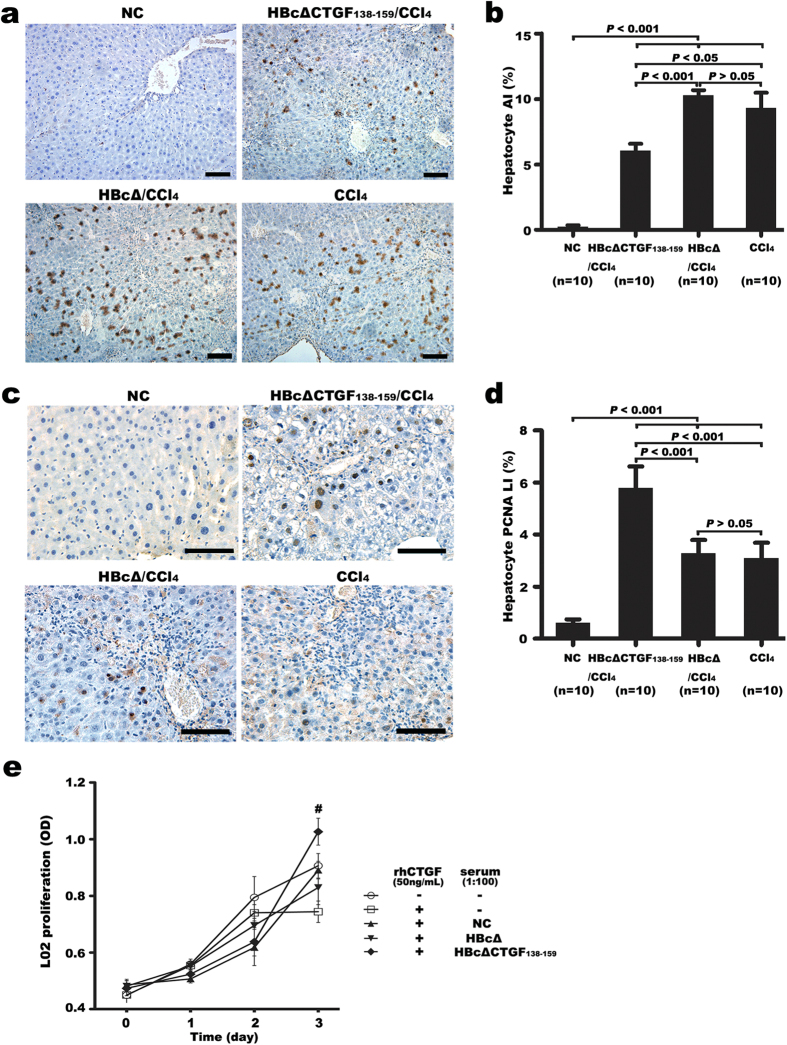
The neutralization of CTGF promoted the proliferation and reduced the apoptosis of hepatocytes in CCl4-induced fibrotic mouse livers.TUNEL staining of the hepatic sections (a) and subsequent apoptosis index (AI) evaluation (b) demonstrated that HBcΔCTGF138–159 vaccination alleviated hepatocyte apoptosis in the fibrotic mouse livers. Immunohistochemically stained of PCNA (c) and subsequent PCNA labelling index (PCNA LI) calculations (d) showed that vaccination with HBcΔCTGF138–159 promoted the proliferation of hepatocytes in CCl4-intoxicated mouse livers. An in vitro experiment with L02 cells revealed that rhCTGF (50 ng/mL) inhibited the proliferation of L02 cells while the neutralization of rhCTGF with the anti-HBcΔCTGF138–159 serum abolished this effect (# vs , P > 0.05;  vs  or , P > 0.05) (e). Scale bars = 100 μm. Error bars indicate the SEM. TUNEL, terminal deoxynucleotidyl transferase-mediated dUTP-biotin nick end labelling assay; PCNA, proliferating cell nuclear antigen; rhCTGF, recombinant human connective tissue growth factor.